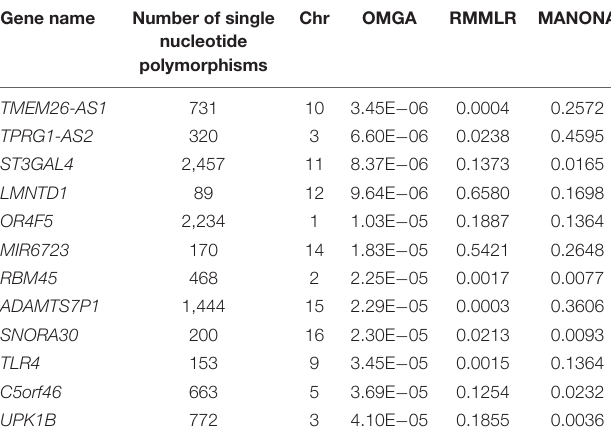
TABLE 3 | List of top genes and the p -values with different methods in the Alzheimer Disease Neuroimaging Initiative